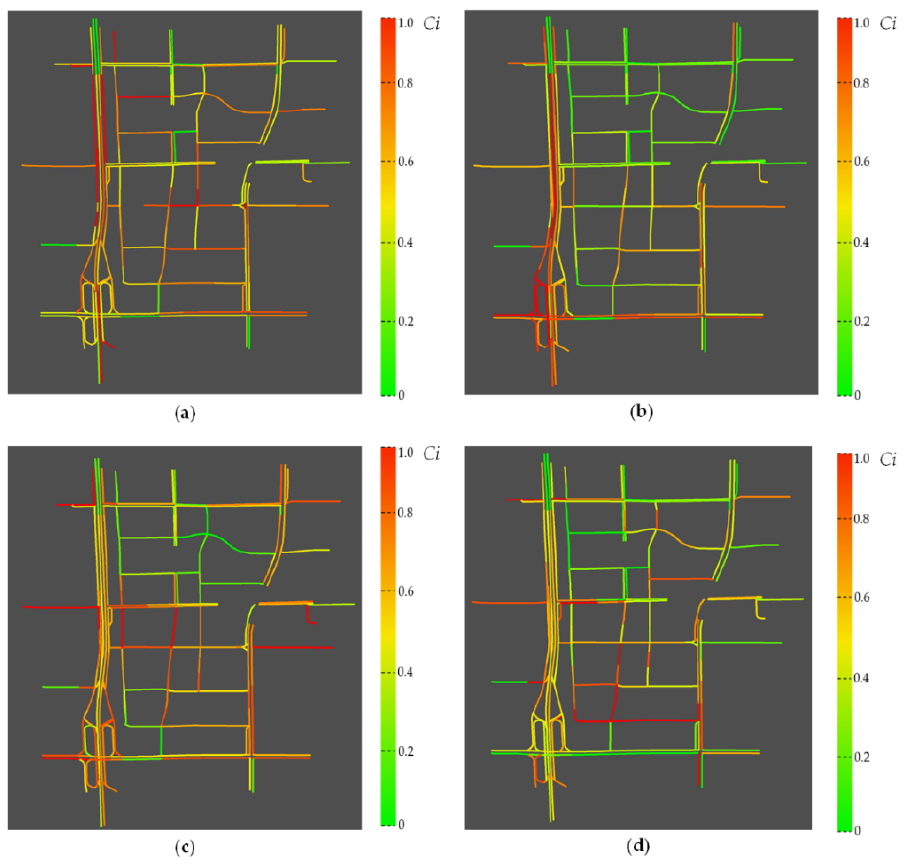
Figure 8. Distribution of critical road sections in the: ( a ) Morning Peak Period; ( b ) Daytime Ordinary Period; ( c ) Evening Peak Period; and ( d ) Evening Ordinary Period.